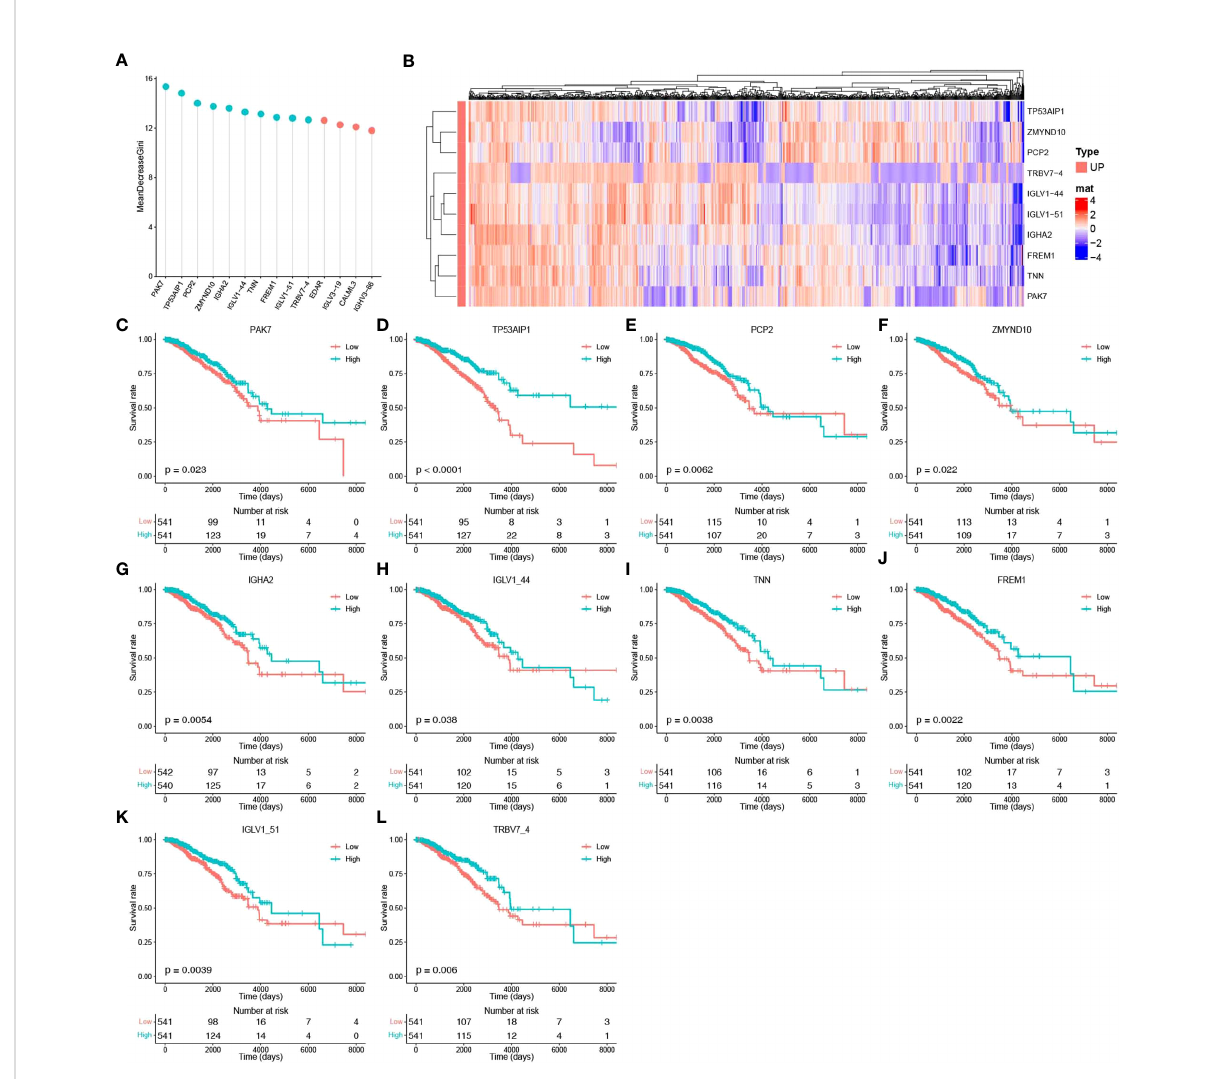
FIGURE 3 Identi fi cation of core pyroptosis-related genes and relationship between the expression of these genes and survival. (A) MeanDecreaseGini score after RF modeling of potential scores (light blue indicates the top 10 pyroptosis factor scores). (B) Heat map of the association between the level of expression of the top 10 pyroptosis factors and breast cancer survival. (C – L) Survival analysis of the pyroptosis